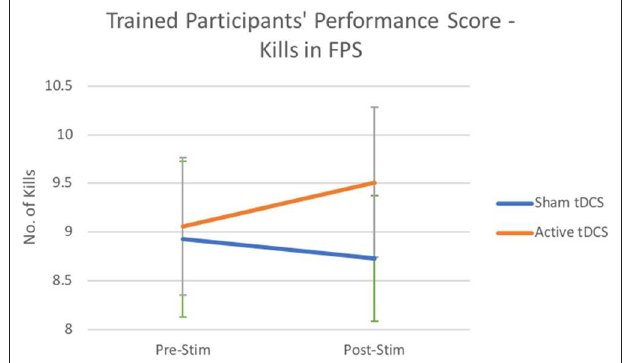
FIGURE 2 | Number of kills performance scores from trained participants after Active Stimulation and Sham Stimulation. Bars—Standard